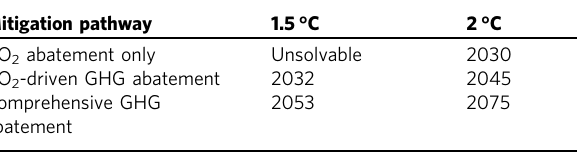
Table 1 Net-zero CO 2 emission years necessary to achieve 1.5 °C and 2 °C